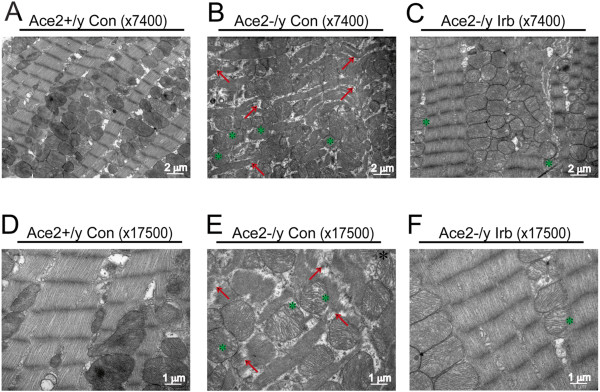
Effects of irbesartan on myocardial ultrastructure injury in ACE2KO mice. The myocardial ultrastructural changes were observed in Ace2+/y control (A,D), Ace2-/y control (B,E) and irbesartan (Irb)-treated Ace2-/y mice (C,F) by transmission electron microscope analysis (×7400 and × 17500 magnification). Compared with Ace2+/y mice, severe myocardial ultrastructure injury was observed in Ace2-/y mice, characterized with disruption or dissolution of myocardial myofilaments, myofilaments arranged irregularly and loosely (red arrow), and vacuolar degenerational and swollen mitochondria (green star).